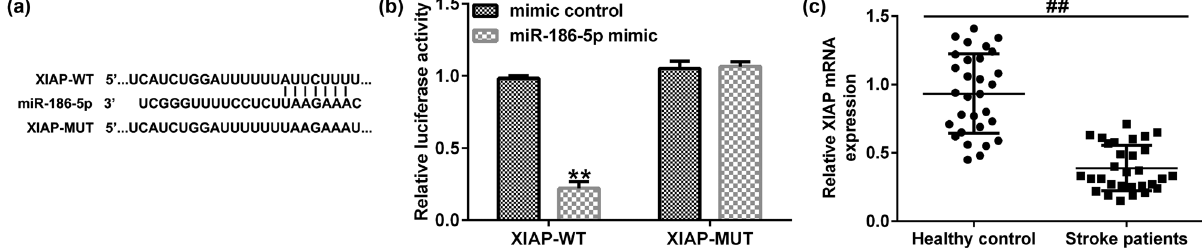
Figure 5: XIAP is directly targeted by miR - 186 - 5p. ( a ) The interaction between miR - 186 - 5p and XIAP 3 ′ - UTR was predicted by TargetScan. ( b ) A dual luciferase reporter gene assay was performed to verify the interaction between miR - 186 - 5p and XIAP in 293T cells co - transfected with miR - 186 - 5p mimics and WT or MUT XIAP 3 ′ - UTR reporter plasmids. ( c ) Expression levels of XIAP in blood samples of patients with ischemic stroke and healthy individuals. ** P < 0.01 vs control mimics group; ## P < 0.01 vs Healthy control group. GraphPad Prism 6.0 software ( GraphPad Software, Inc. ) was used for creation of the fi